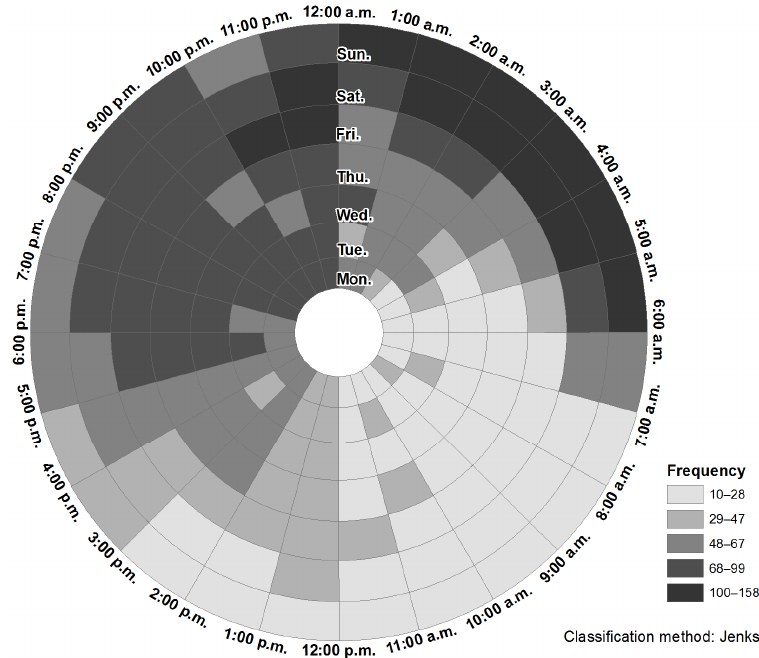
Figure 1. Street robberies from 2009 to 2013 by time of day and by weekday.